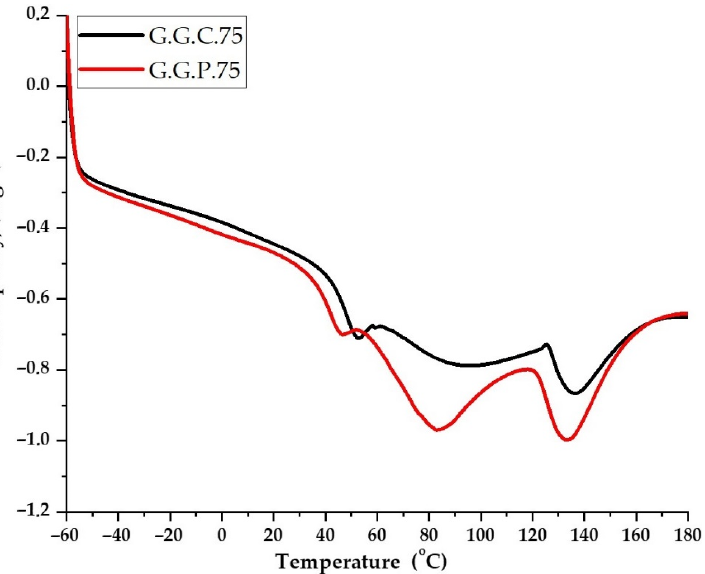
Figure 10. Differential scanning calorimetry (DSC) for composites filled with casein (5 PBW G.G.C.75) and red phosphorus (5 PBW